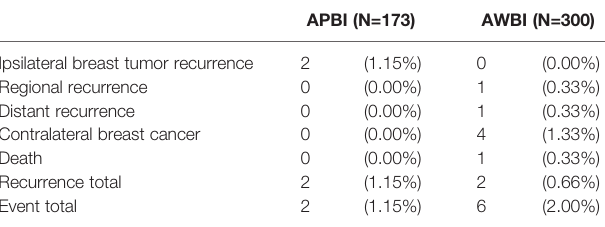
TABLE 2 | Event type by treatment